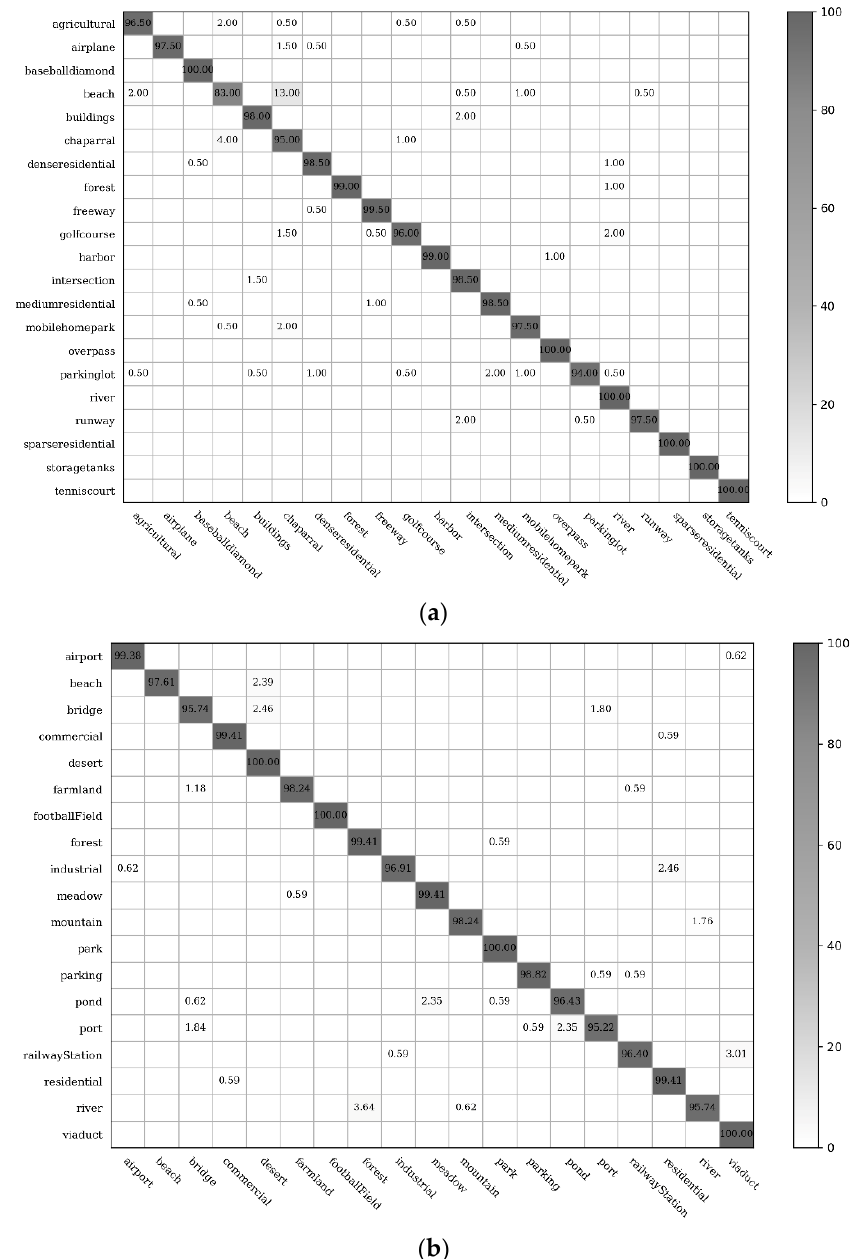
Figure 10. The confusion matrices showing the classification accuracies (%) for the proposed model. ( a ) Confusion matrix for the UC Merced dataset; ( b ) Confusion matrix for the WHU-RS dataset.